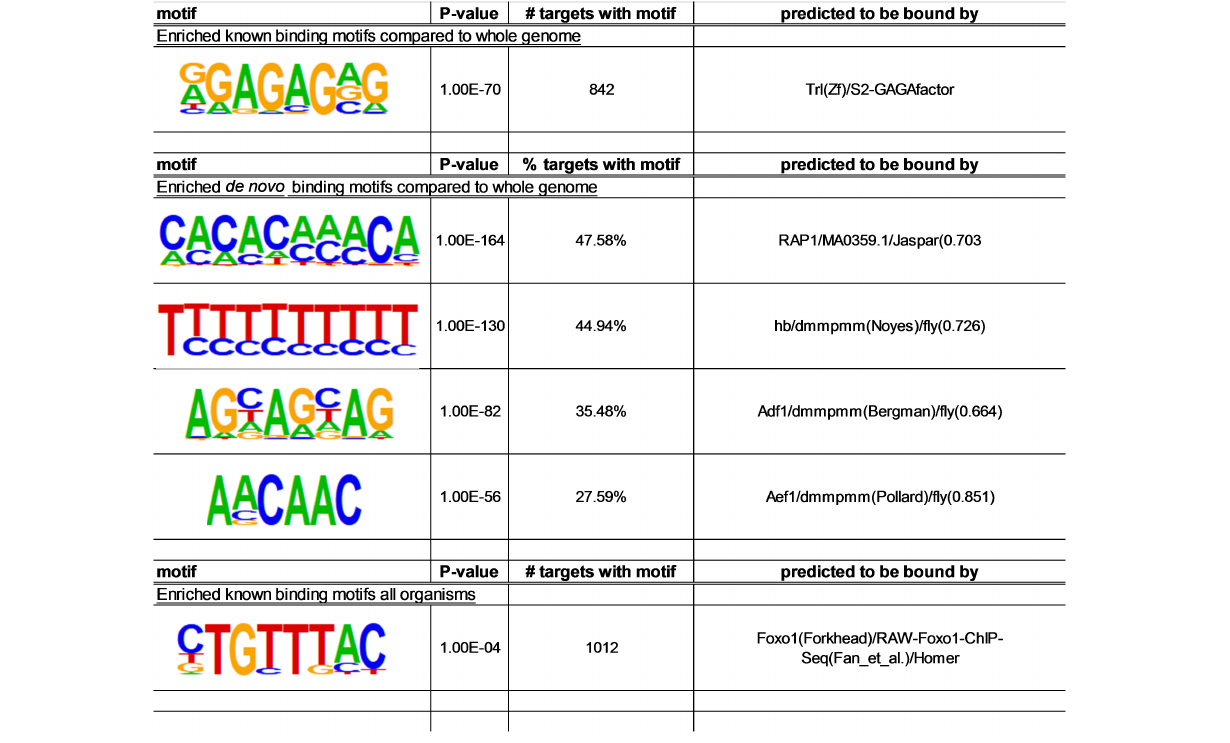
and its coactivator (PGC-1 α ) interact with FOXO and